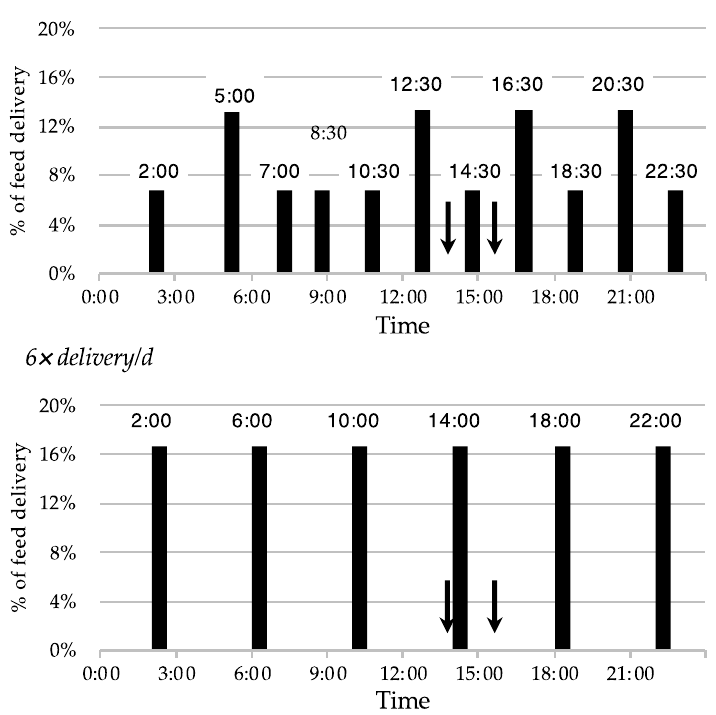
Figure 2. Feeding timetables with time of each delivery and quantity of feed delivered in percentage of MR. Bold arrows indicate times at which the feed was pushed up during the day (13:45 and 15:45).